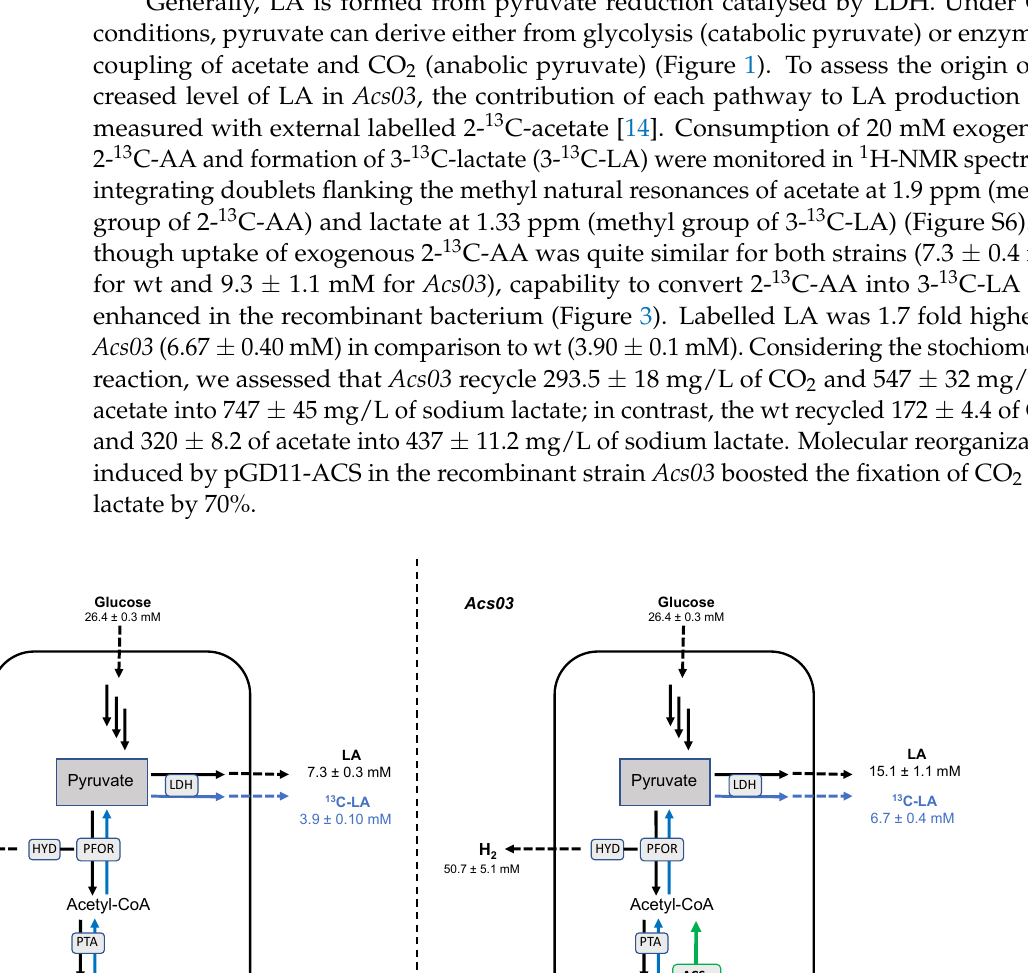
Table 2. Ratio of lactate (LA) and acetate (AA) yield in wild type (wt), empty vector, and ACS recombinant strain ( Acs03 ). LA/AA wt 0.44 Empty vector 0.36 Acs03 1.5